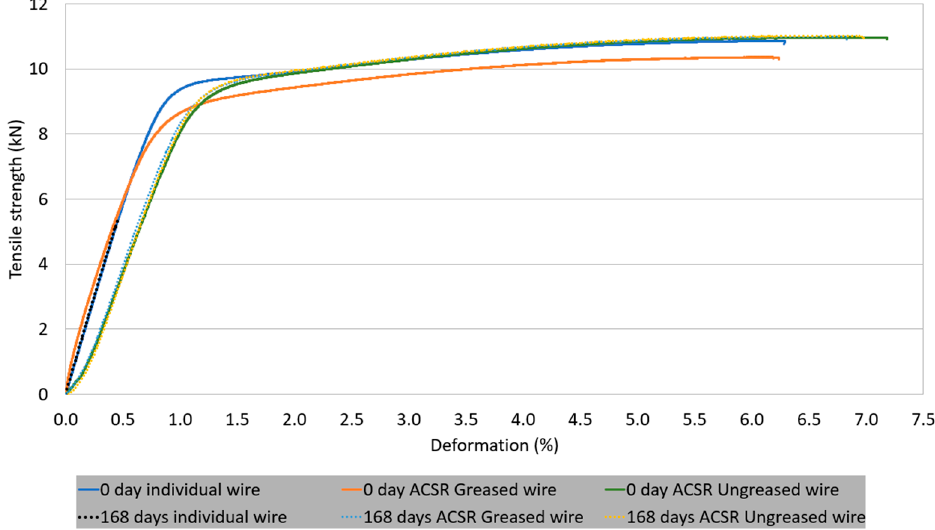
Figure 15. Tensile strength deformation evolution on corroded steel wires.